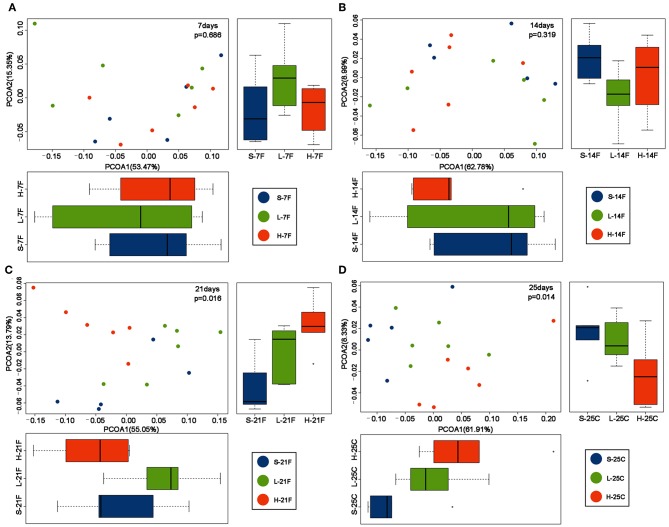
PCoA plots of β-diversity of feces collected on day (A) 7th day; (B) 14th day; (C) 21st; and cecal contents collected on day (D) 25th. Results revealed samples from spirulina treatment clustered separately from the saline group on the 21st and 25th days. The colonic microbial community structures were compared between treatments using the PCoA based on the weighted UniFrac distance matrixes. MRPP analysis was used to determine the statistical significance with p < 0.05. Each time point contains 5 or 6 samples. S (purple), L (green), and H (orange) represent saline, low, and high doses of spirulina, respectively, and F and C represent feces and cecum, respectively. Colored dots indicate the sample from each animal.